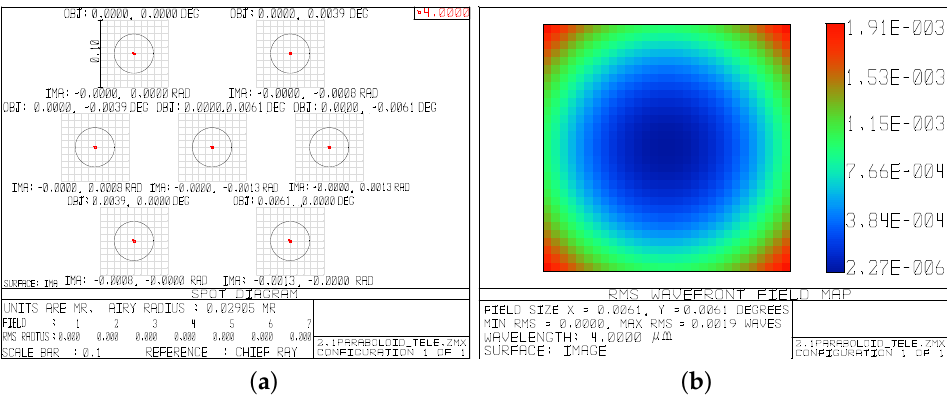
Figure 5. ( a ) Spot diagram at different FOVs of telescope output. Red spots, image spots; black circles, Airy spots. FOV and parallelism of output beams shown above and below each box, respectively. Imaging spots in the required FOV were far smaller than Airy spots. ( b ) RMS WFE map over full FOV at telescope